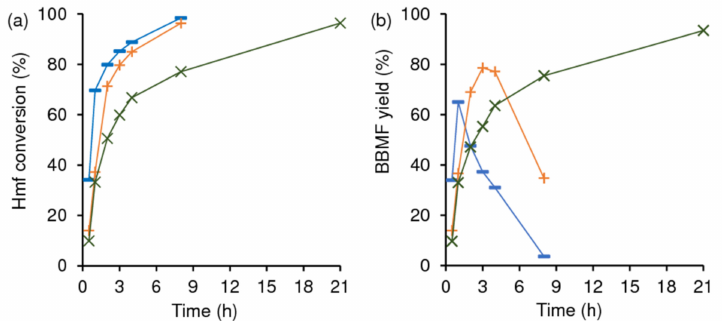
Figure 8. Influence of the molar ratio Si/Hf of the Hf-TUD-1(x) catalysts (x = 25 ( − ); x = 50 (+); x = 75 (x)) on Hmf conversion ( a ) and BBMF yield ( b ) at 150 ◦ C. Reaction conditions: 0.2 M Hmf in 2BuOH, 20 g cat L − 1